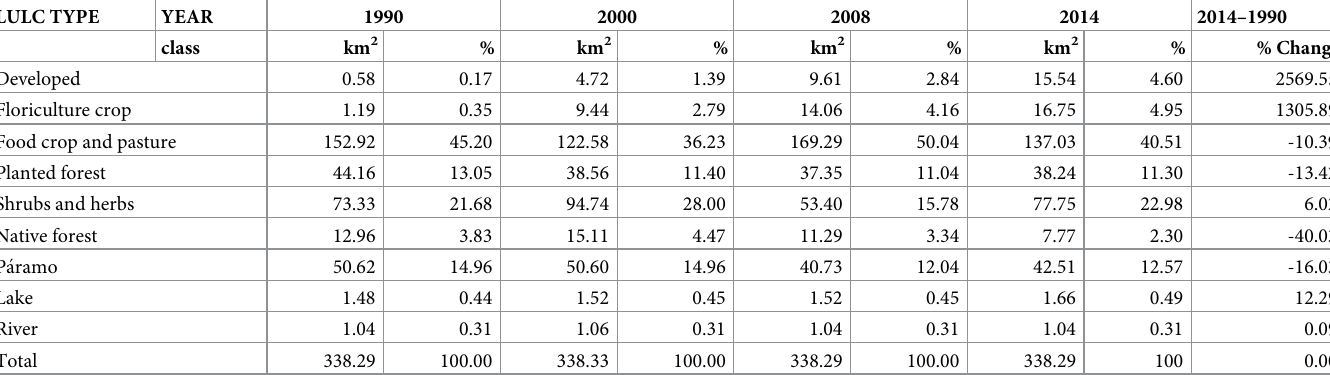
Table 2. Changes in land cover classification in Pedro Moncayo county from 1990 to